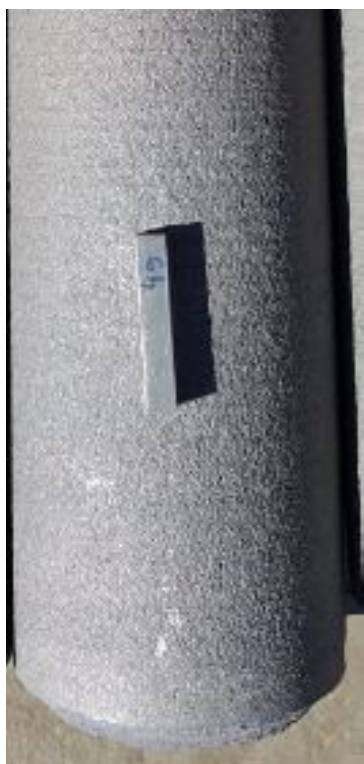
Figure 4. Tensile specimens dimensions (mm).